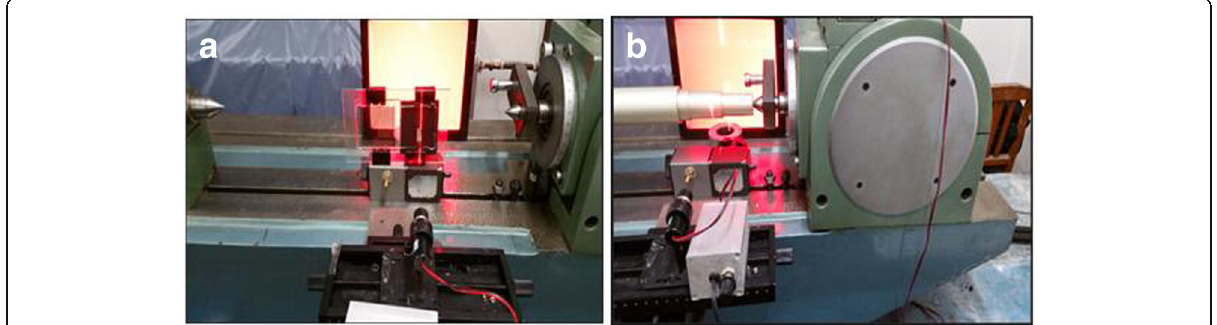
Fig. 13 Experimental equipment for image enhancement algorithms. a The linear light stripe b The arc light